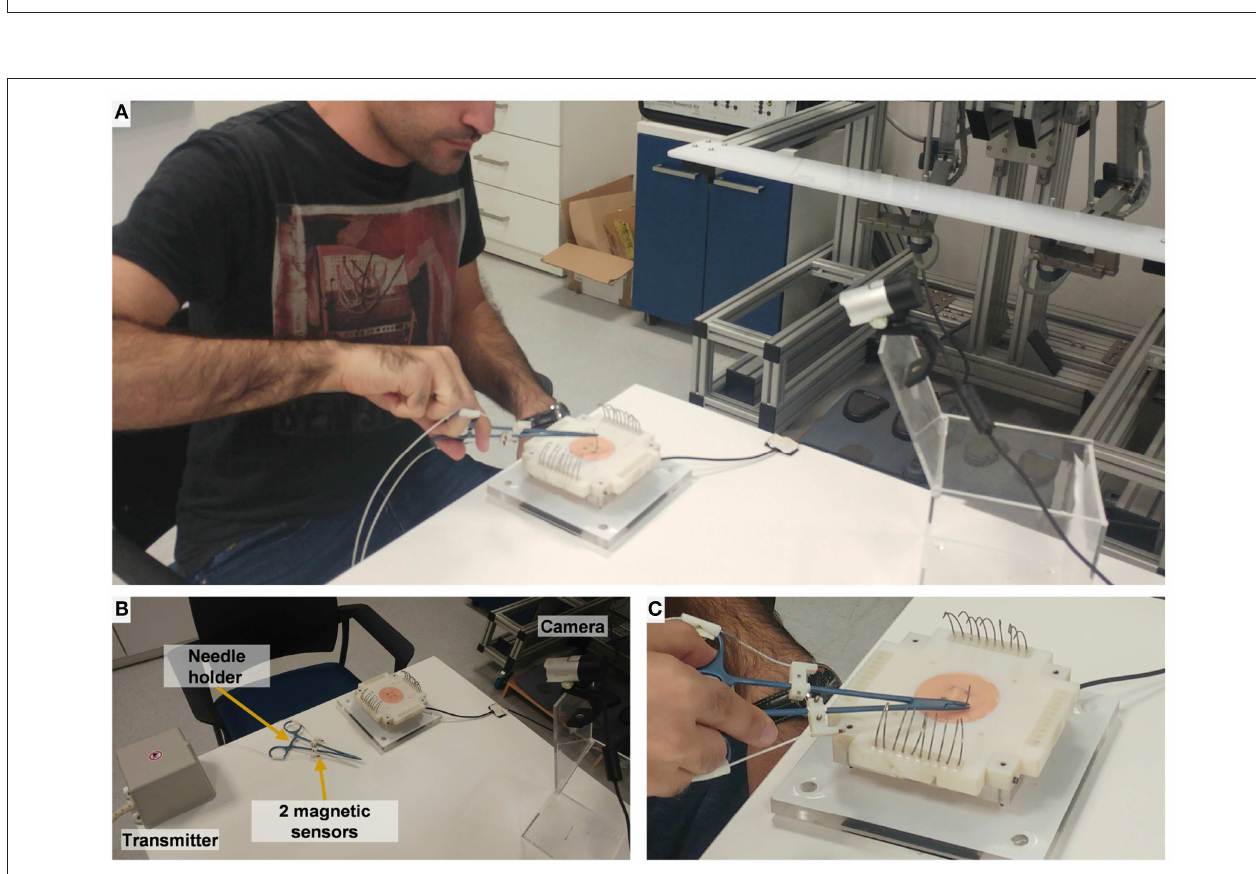
FIGURE 4 | Experimental setup for open needle driving. (A) The participant performs open needle driving using a titanium needle holder. (B) Magnetic transmitter records 6 DOF pose of the 2 magnetic sensors. (C) Artificial tissue, fixture, and F/T sensor setup (identical to the teleoperated conditions).